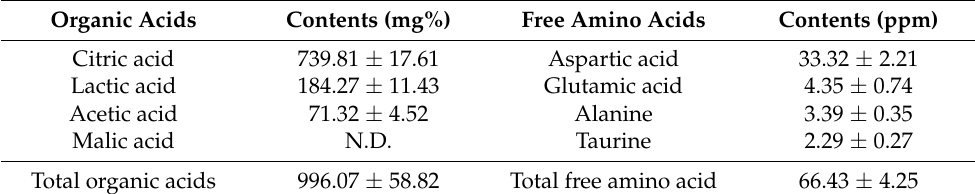
Table 2. Contents of organic acids and free amino acids in FP.